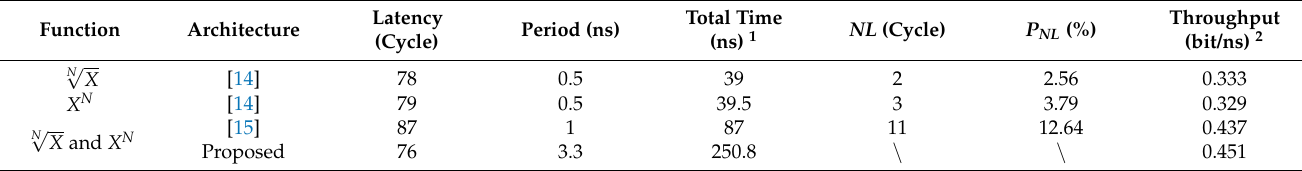
Table 6. Timing analysis for [14,15] and the proposed architecture.